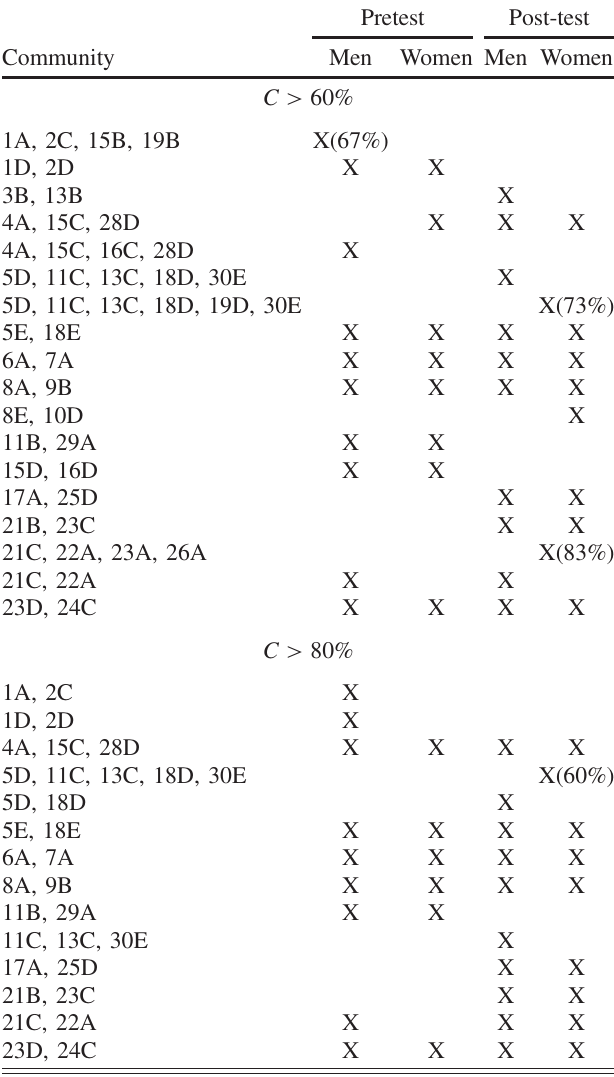
TABLE I. Communities identified in the pretest and post-test incorrect answers at r > 0 . 2 and differing levels of the commu- nity fraction C . The number in parenthesis is the intracommunity density γ for communities where the intracommunity density is not